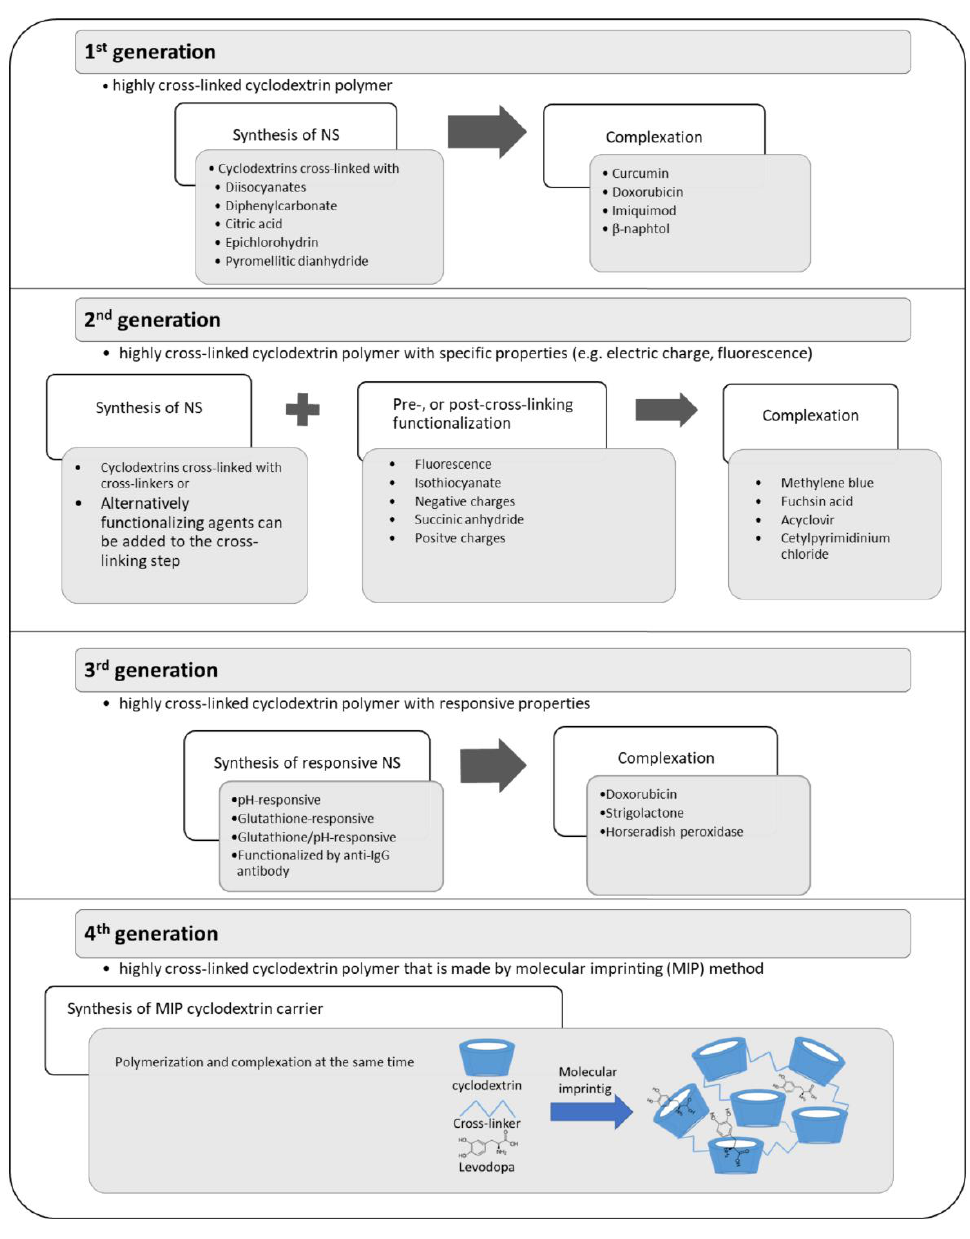
Figure 5. Generation of nanosponges (NS) . (References: 1st generation [64–70], 2nd generation [71– 75], 3rd generation [76–79], and 4th generation